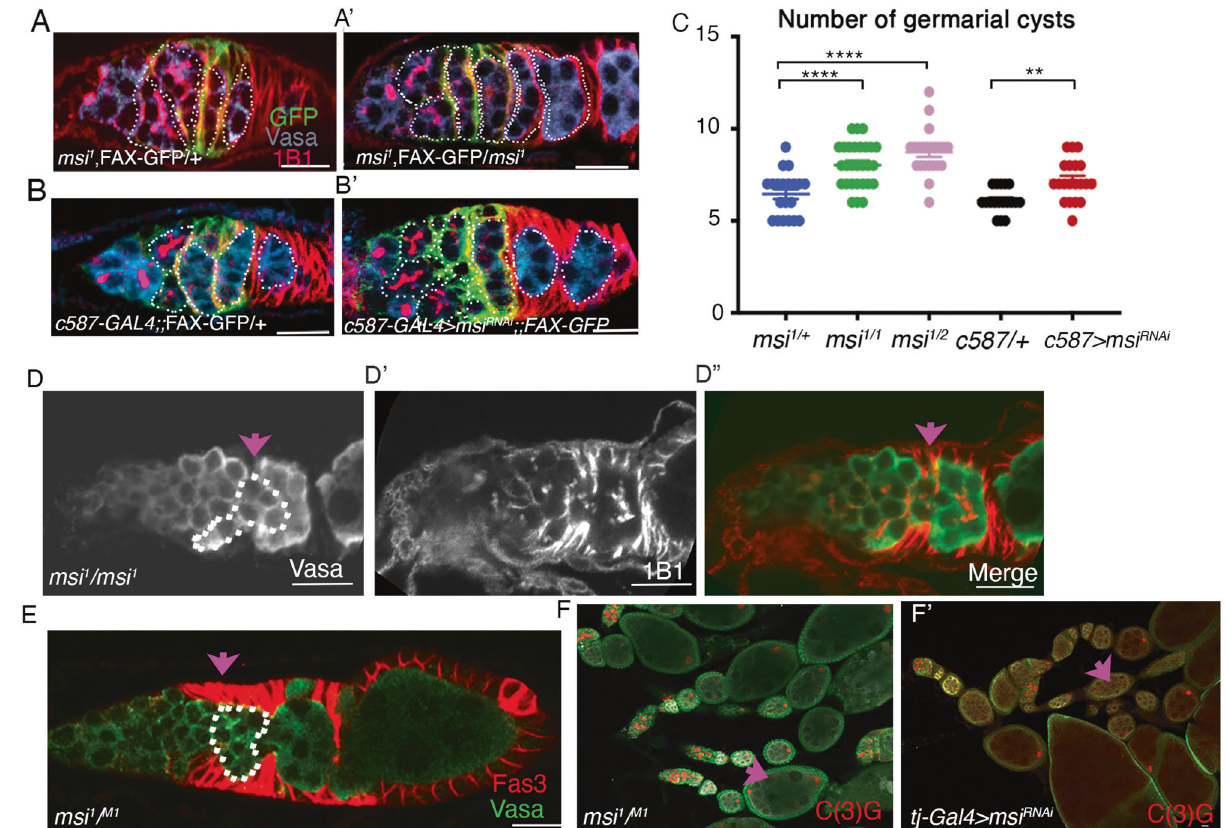
Fig. 2 Loss of Msi from somatic cells results in an increase in the number of germarial cysts, germline cyst collisions in region 2a/2b and fused egg chambers. A , B ’ Confocal micrographs of control ( A and B ), msi null ( A ’ ) and C587-Gal4 > UAS-msiRNAi ( B ’ ) germaria. Germline cysts (dotted outlines) were counted in germaria labelled with Vasa (germ cells), 1B1 (fusomes showing connections between germ cells), and FAX- GFP, a marker of escort cell cytoplasm. C Scatterplot of the average number of 4 – 16 cell germline cysts in regions 1 to 3 of germaria (±SEM) dissected from heterozygote msi 1/ + (blue; 6.45 ± .27; N = 20), msi 1/1 (green; 8.04 ± .23; N = 28), transheterozygote msi 1/2 fl ies (pink; 8.73 ± .27; N = 22), C587GAL4 > + (black; 6.11 ± .26) and C587GAL4 > msi RNAi (7.2 ± .25). Welch ’ s two-tailed t tests reveal a signi fi cant increase in the average number of cysts in both msi null and msi 1/2 mutants compared to control msi 1/ + germaria ( p < 0.0001 in both cases) and in C587- GAL4 > + control germaria ( N = 18) compared to germaria dissected from C587-GAL4 > msi RNAi fl ies ( N = 20; p = 0.0012). Ovarioles were dissected from a minimum of 8 adult females from each genotype and ovarioles were imaged randomly over two separate sessions. D , E High magni fi cation single-plane confocal micrographs show colliding cysts (pink arrow, dotted outline) in ovaries dissected from msi 1/1 and msi